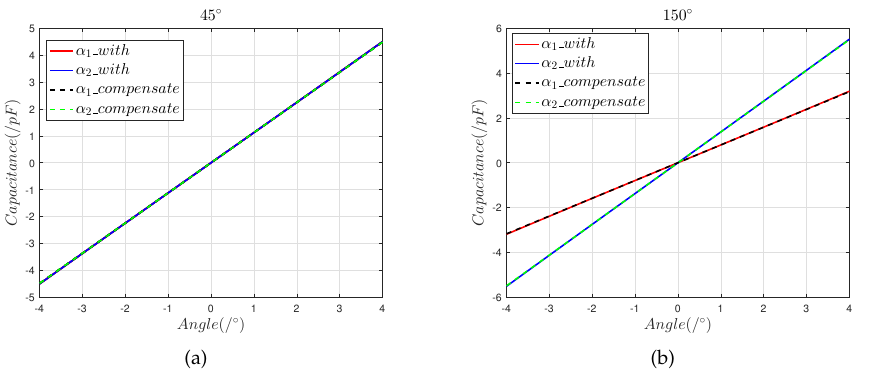
Figure 12. The 50 µ m composite installation error analysis: ( a ) differential capacitance in the 45° direction; ( b ) differential capacitance in the 150° direction.